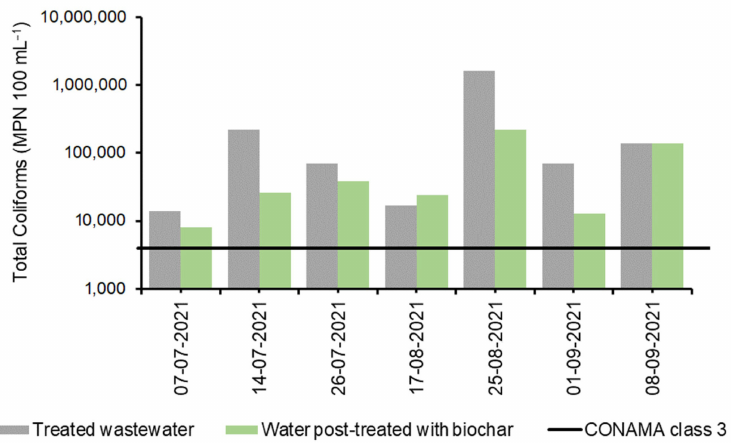
Figure 4. Values of total coliforms present in different water